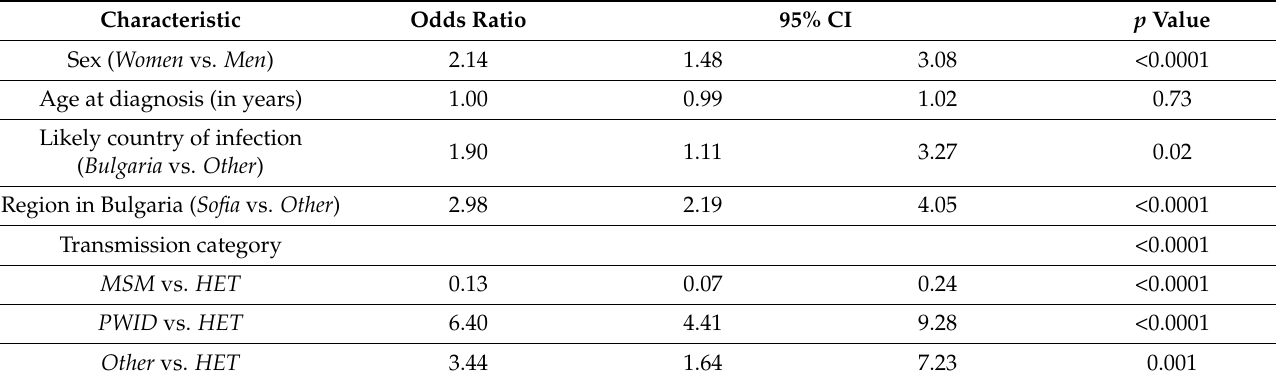
Table 2. Multivariable analysis of selected demographic characteristics comparing HIV-1 CRF01_AE infection to that with other subtypes in